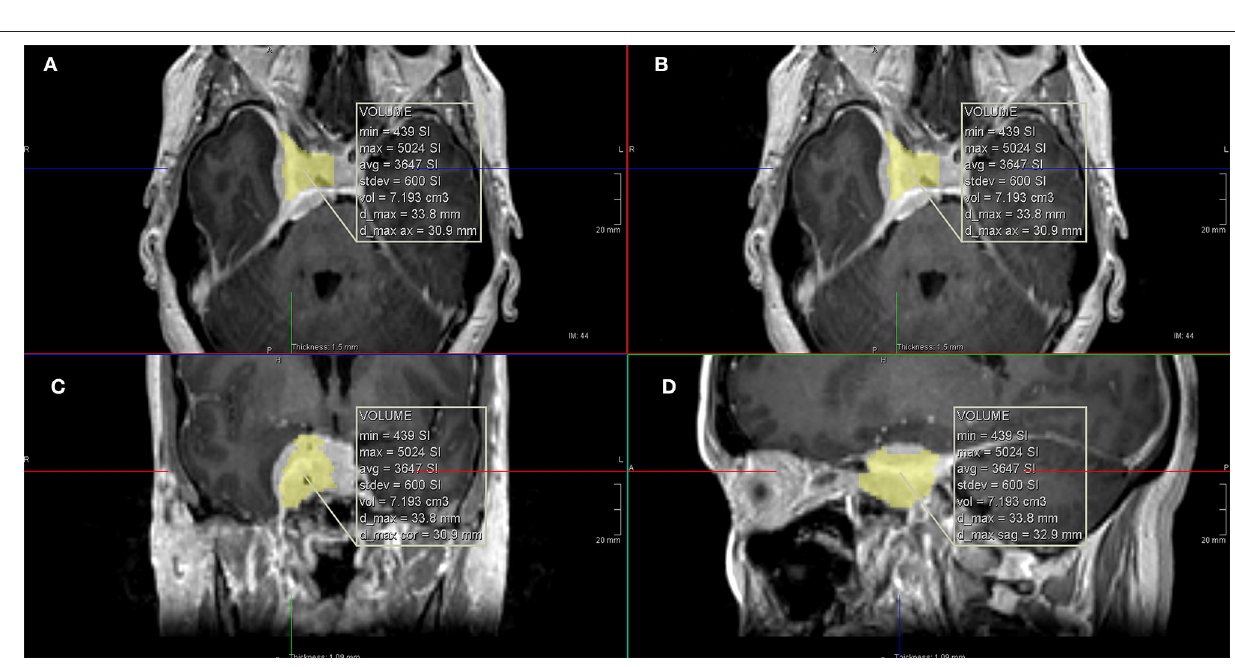
level without affecting the pituitary gland ( Figures 5 , 6 ).